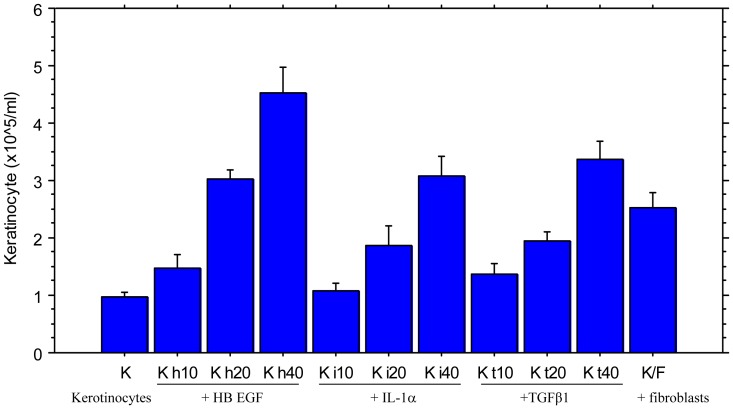
Effects of different cytokines on the growth of Keratinocytes.Keratinocytes and fibroblasts were respectively stained with PHK26 and PHK2 before co-culture. Keratinocytes were cultured with fibroblasts (K/F), or with 10 ng/ml, 20 ng/ml and 40 ng/ml of HB EGF (K h10, K h20 and Kh40), IL-1α (Ki10, K i20 and K i40) or TGFβ1 (K t10, K t20 and K t40), or keratinocytes alone (K). 6-well-plates were used in the culture and cells were resuspended in 10 ml after harvested on day 5 following the culture. Four cultures in each condition. Keratinocytes were counted by Trypan Blue exclusion and Flow Cytometry.